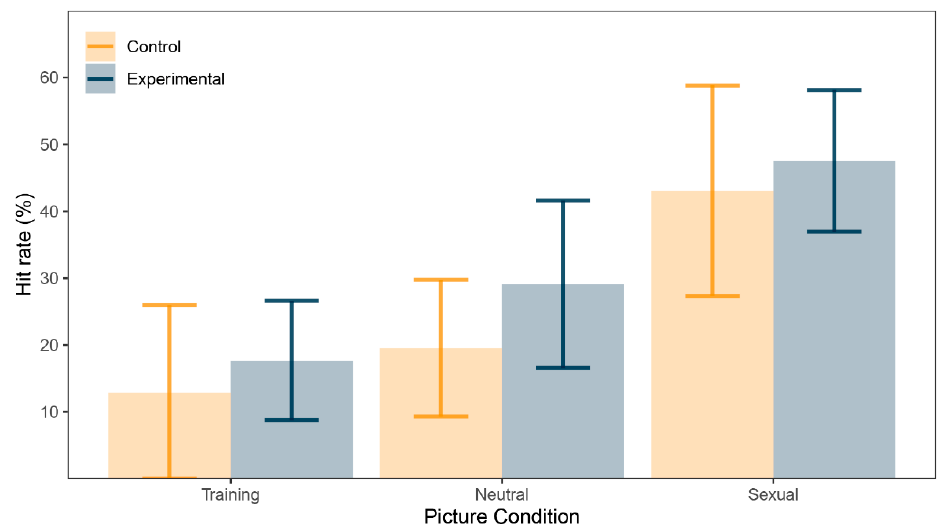
Figure 2. Picture recognition task: means of correct recognitions (%) and 95% confidence intervals for training, neutral, and sexual pictures